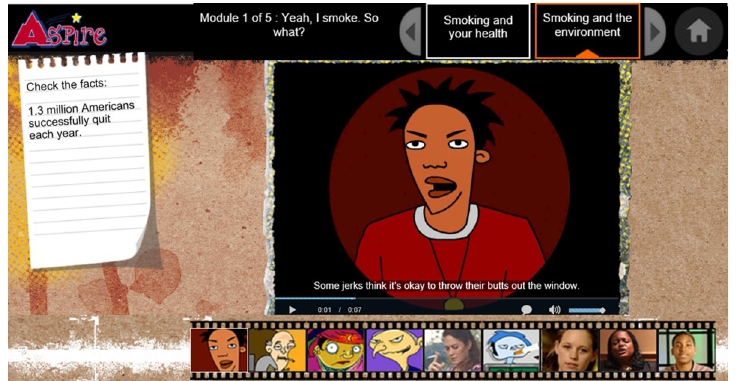
Fig 2. A screenshot of the aspire